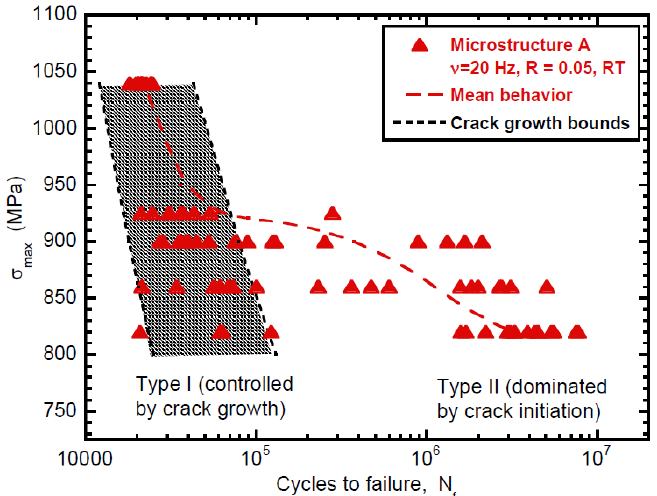
Figure 15. Stress vs. lifetime behavior demonstrating the separation of crack initiation dominated behavior (Type II) from the crack growth-controlled mechanism (Type I) with decreasing stress level [37].